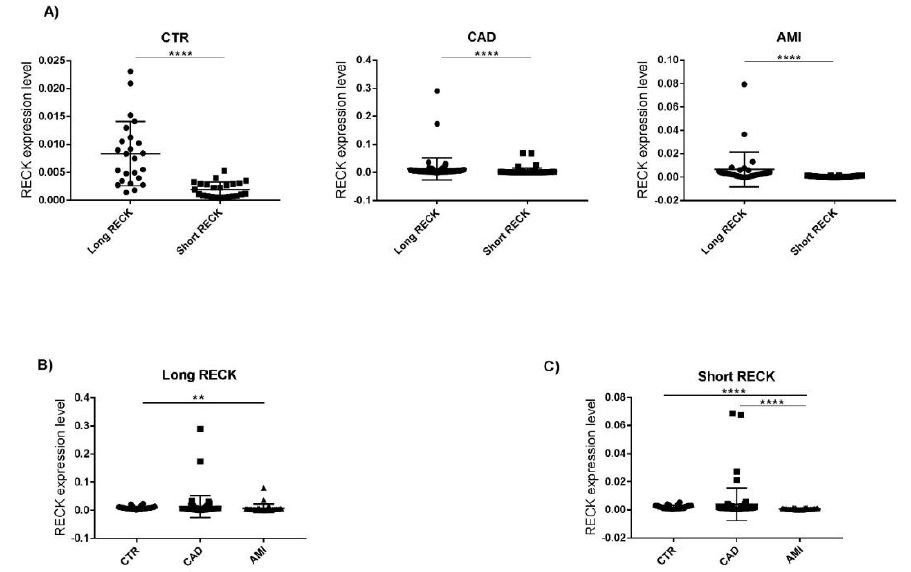
Figure 3. ( A ) Expression level of Long and Short RECK splice variants in CTR, CAD, and AMI group. Wilcoxon test, **** p < 0.0001. ( B ) Expression level of Long RECK in CTR, CAD, and AMI groups. Kruskal–Wallis test, ** p < 0.001. ( C ) Expression level of Short RECK in CTR, CAD, and AMI groups. Kruskal–Wallis test, **** p <0.0001. Expression data are represented as mean ± SD.